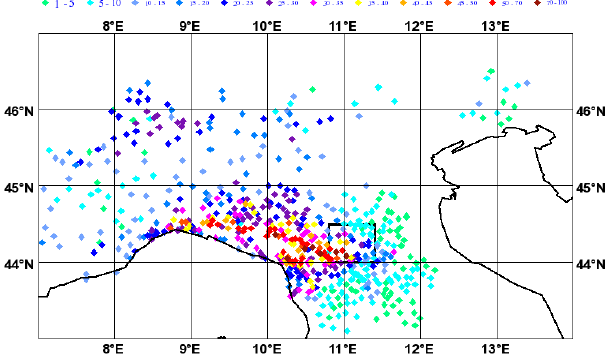
Figure 2. Observed 6-h accumulated precipitation at 00:00UTC, 30 November 2008. Dark blue diamonds correspond to 20– 25mm / 6h. Black rectangle indicates approximately the Reno river basin.